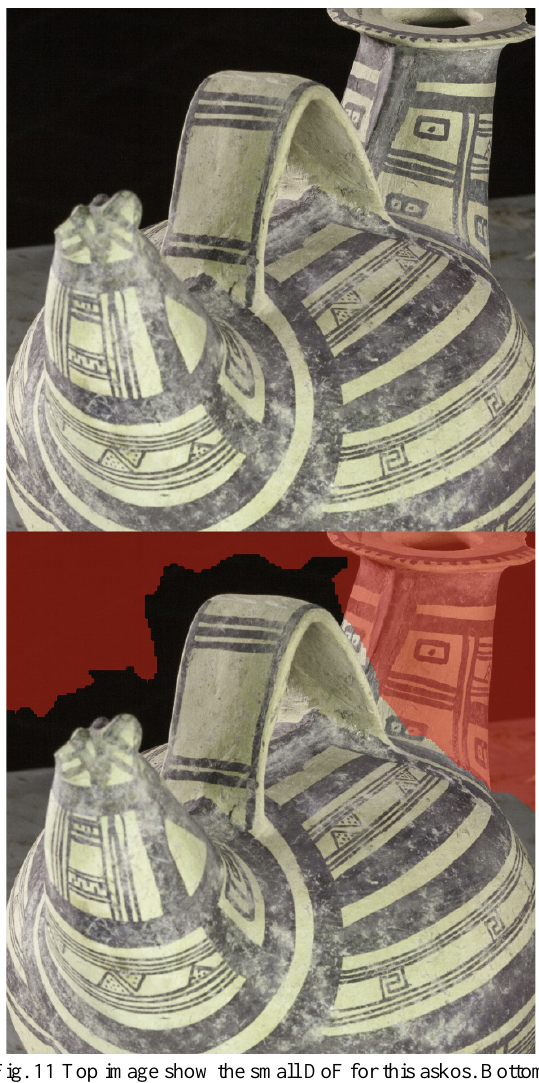
Fig. 11 Top image show the small DoF for this askos. Bottom image show the Auto-Blend area.